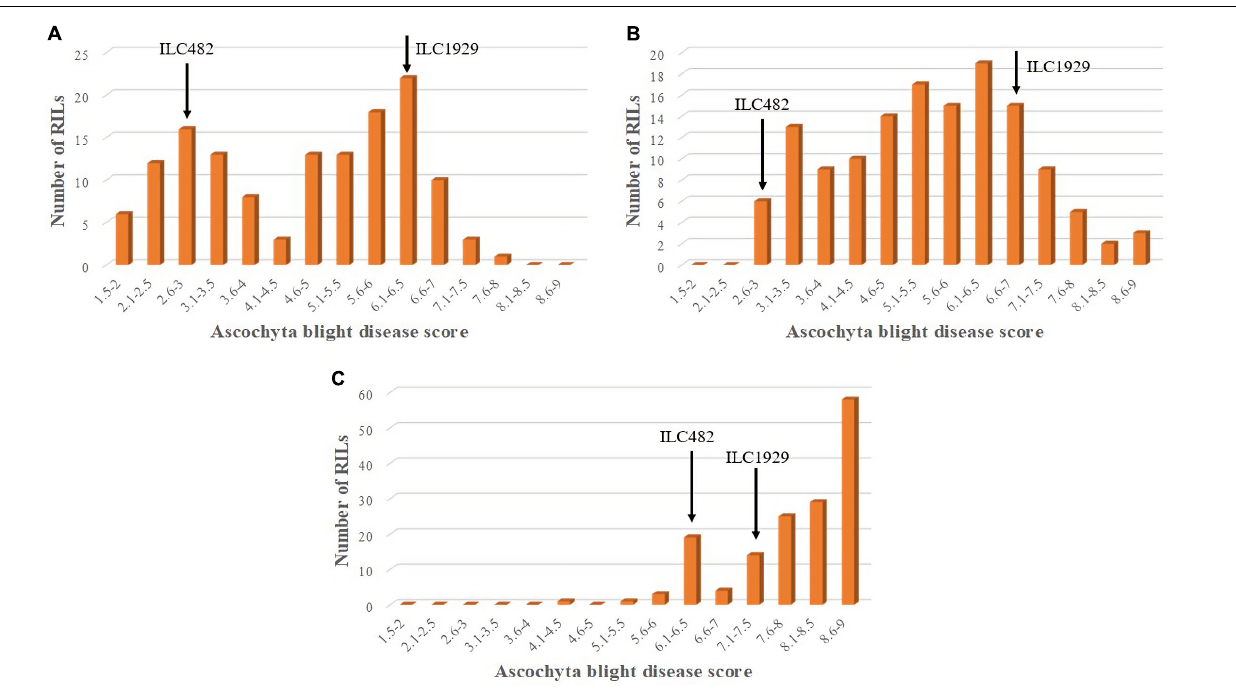
FIGURE 2 | Frequency distribution of AB disease scores in 135 RILs of the AB 482 chickpea population developed from a cross between “ILC1929” and “ILC482.” Mean disease score was used to calculate the frequency distribution of disease scores in the greenhouse experiment repeats for pathotype I under (A) field conditions at Kfarshakhna in 2015 and (B) at PAU Ludhiana in 2017. (C) Arrows show the mean scores of the resistant “ILC482” and susceptible “ILC929”